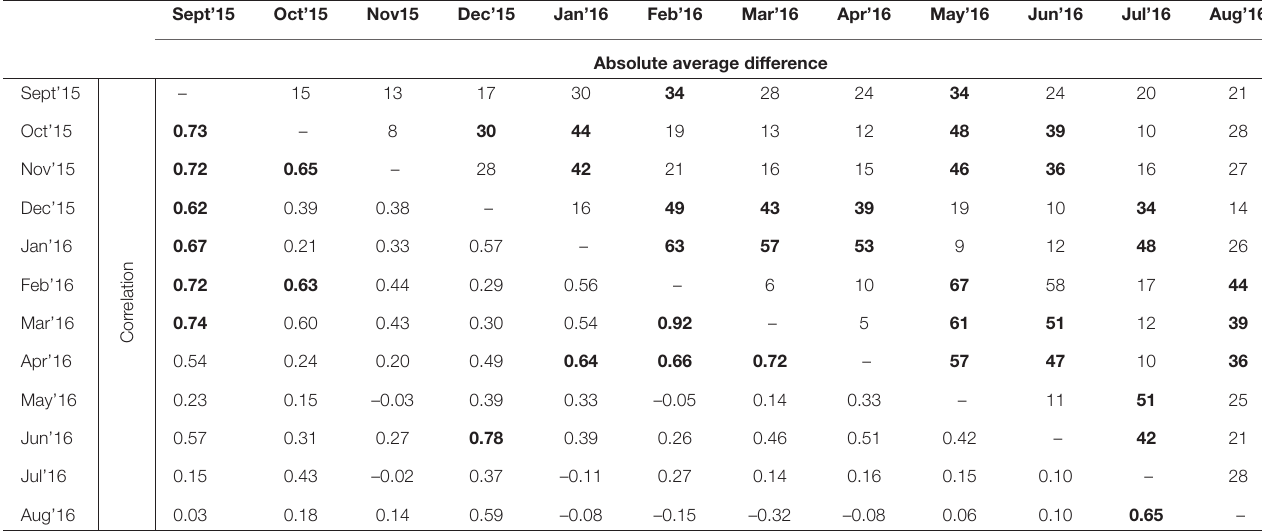
FIGURE 3 | Resistance surfaces developed in multi-scale framework for each month from September 2015 to August 2016. Brown line indicates sections of Kruger National Park: 1- Crocodile Bridge; 2- Houtboschrand; 3- Kingfisherspruit; 4- Letaba; 5- Lower Sabie; 6- Mjejane Contractural; 7- Malelane; 8- N’wanetsi;9- Olifants; 10- Pretoriuskop; 11- Phalaborwa; 12- Pretoriuskop (outside KNP); 14- Satara; 15- Skukuza/private reserves (outside KNP); 16- Skukuza; 17- Stolsnek; 18- Tshokwane. Red color indicates high resistance (elephants repelled) and blue low resistance (elephants attracted). TABLE 2 | Pearson’s correlation and absolute average difference between 12 resistance surfaces representing 12 months from September 2015 to December